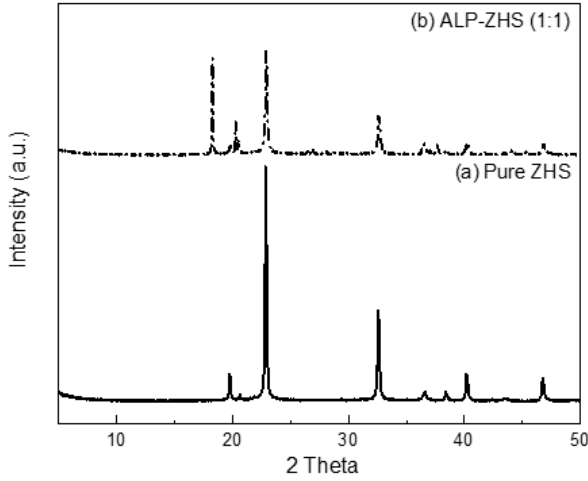
Figure 4. XRD patterns of ( a ) pure ZHS and ( b ) ALP-ZHS (1:1) composite prepared at 50 °C for 1.5 h.